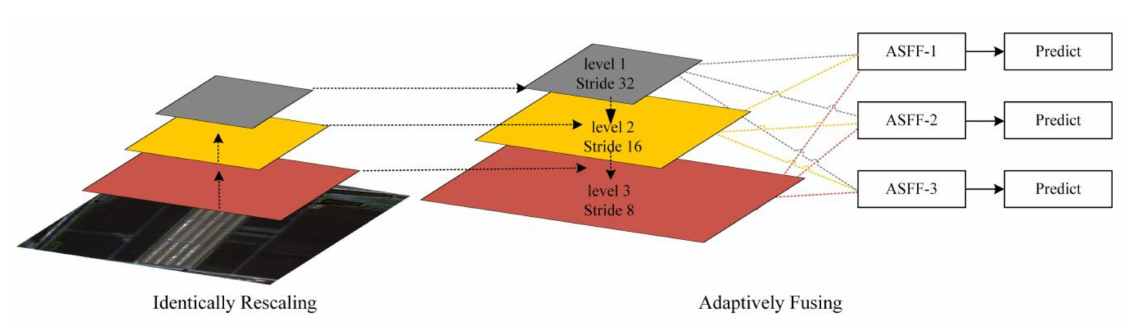
Figure 5. The specific process of weighted feature fusion of ASFF